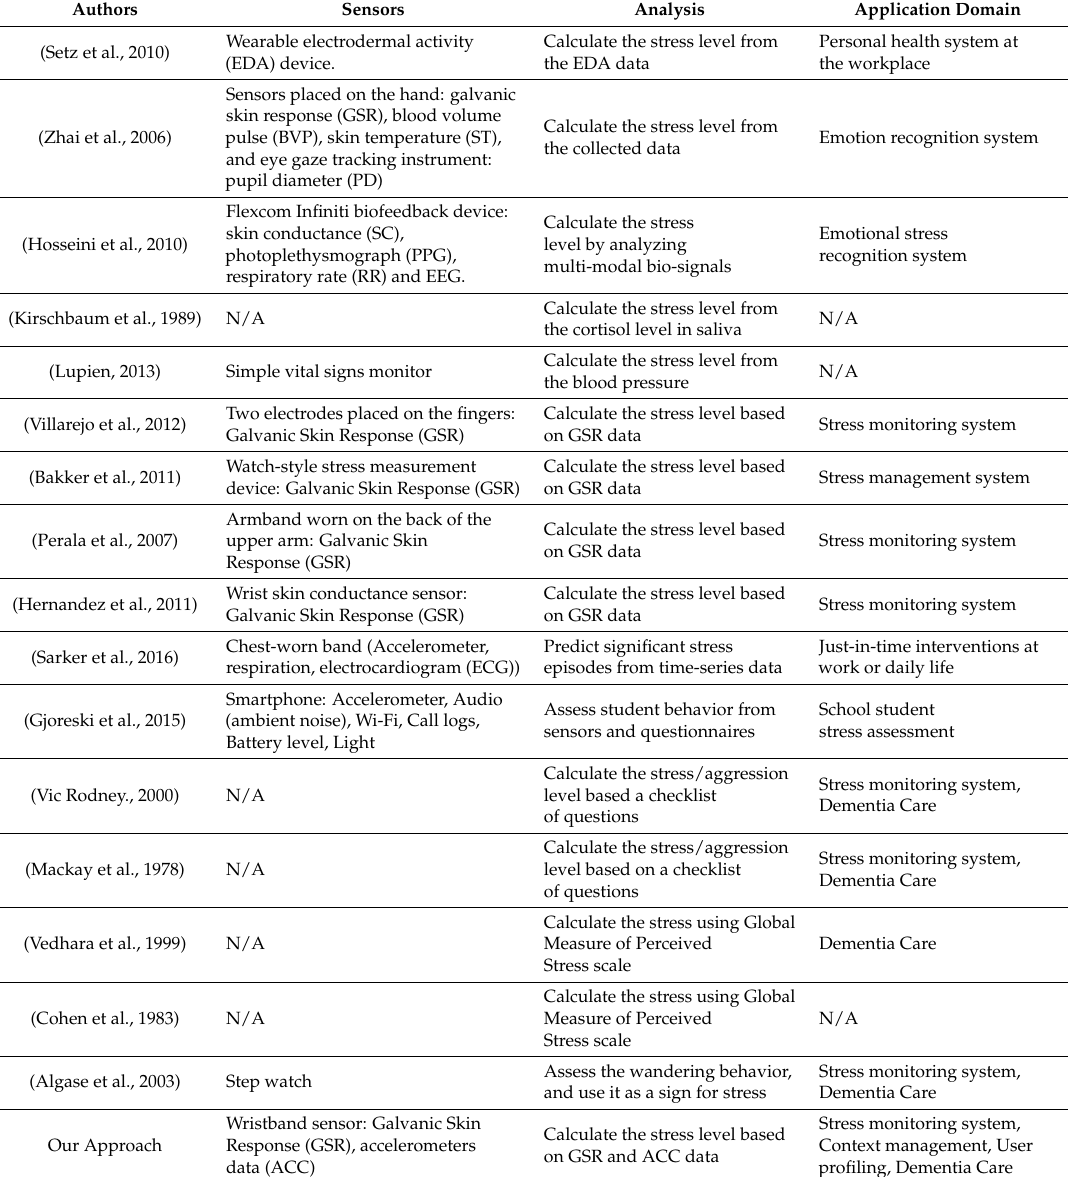
Table 1. Comparison of the related